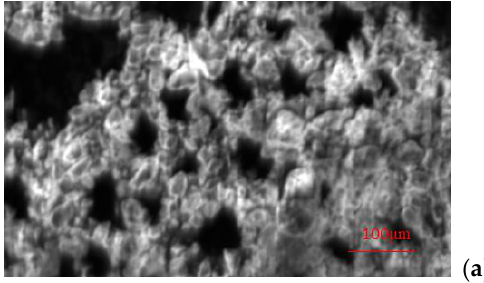
Table 1. Main properties of Tunisian and Romanian soils.